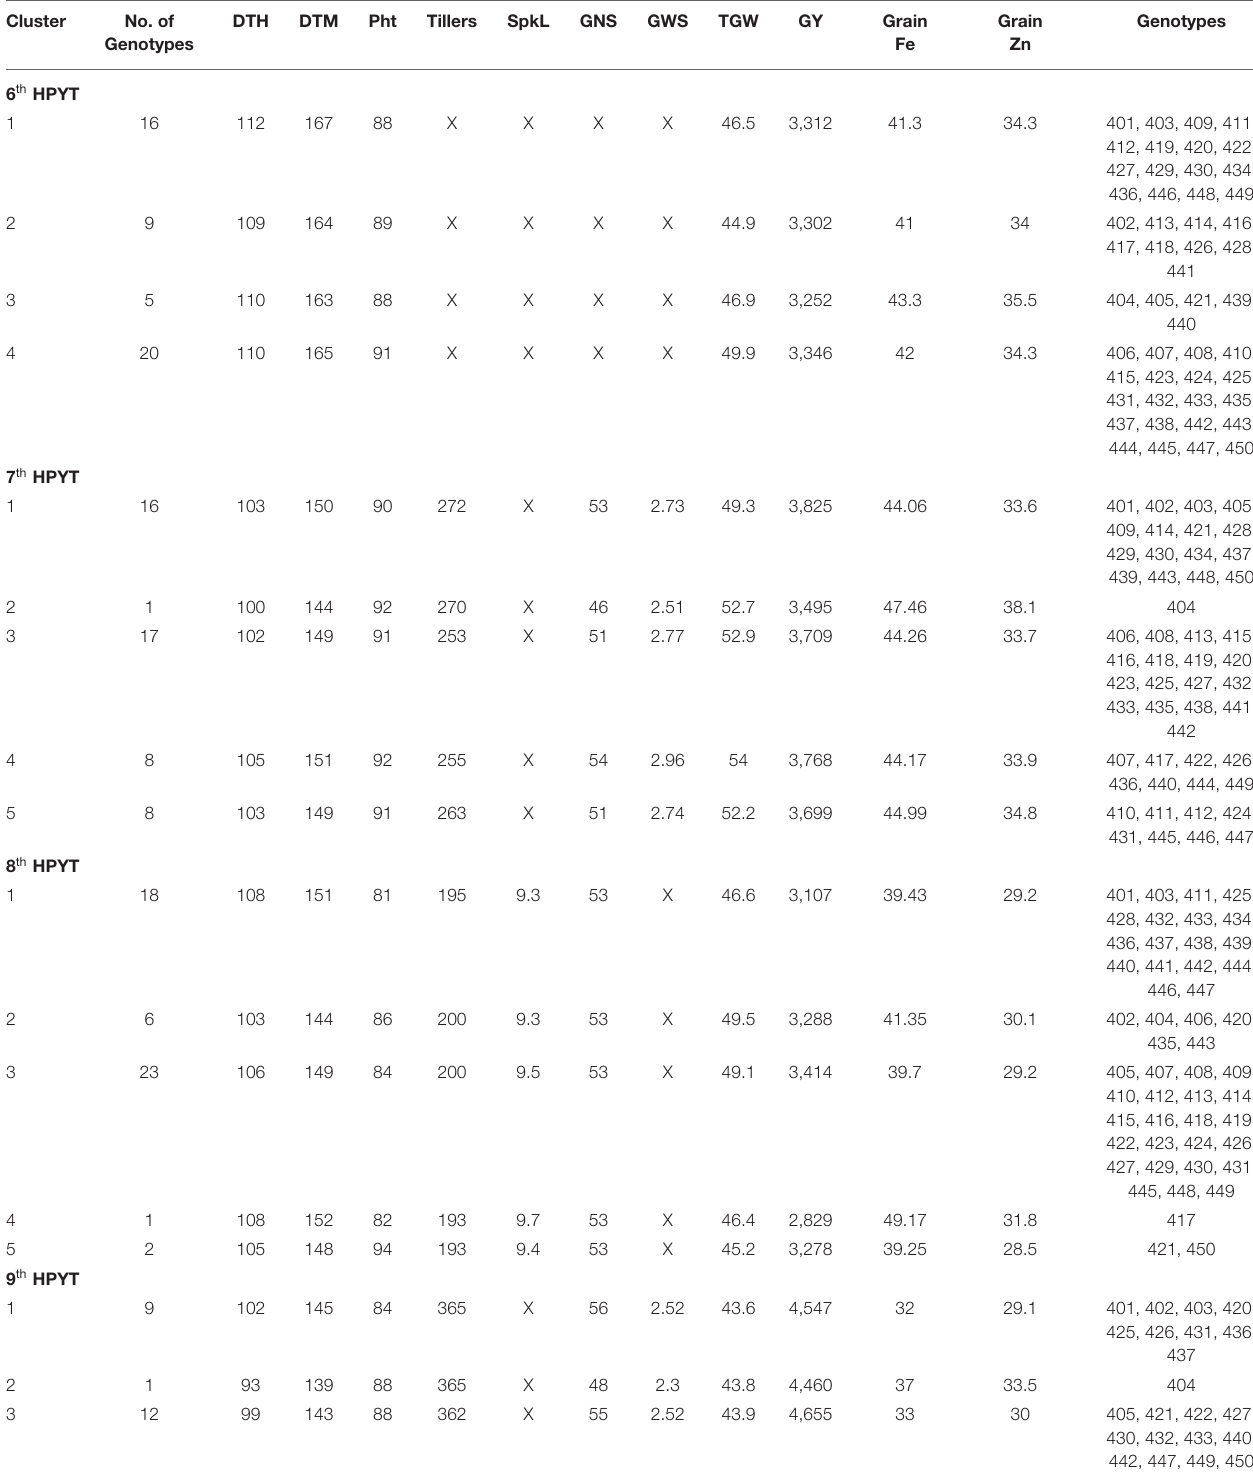
TABLE 3 | Cluster mean of the 6th HarvestPlus Yield Trial (2015–16), 7th HarvestPlus Yield Trial (2016–17), 8th HarvestPlus Yield Trial (2017–18), and 9th HarvestPlus Yield Trial (2018–19). Cluster No. of Genotypes